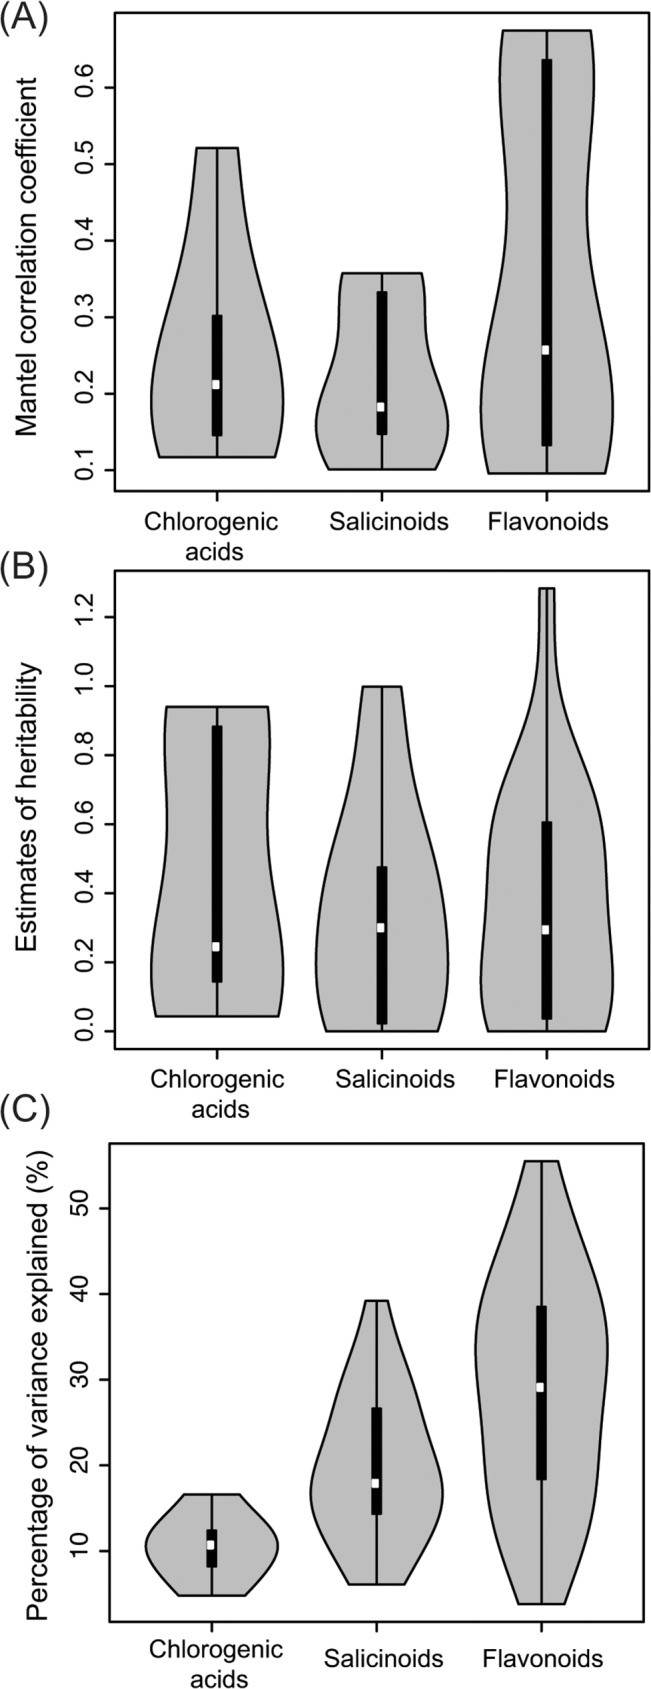
Indicators of genetic determination of phytochemical traits representing different branches of the phenylpropanoid pathway.Violin plots indicate medians (white dots), quartiles (thick black bars) and probability distributions (grey areas) of different surrogates of the degree of genetic determination or heritability in different branches of the phenylpropanoid pathway. (a) Significant Mantel correlation coefficients between phenotype and genotype in the Ticino river valley hybrid zone (Italy). (b) Estimates of heritability (h2) in hybrid seedlings from maternal families in the common garden. (c) Percentage of variance explained (PVE) by QTL for phytochemical traits detected by genetic mapping in natural hybrids.